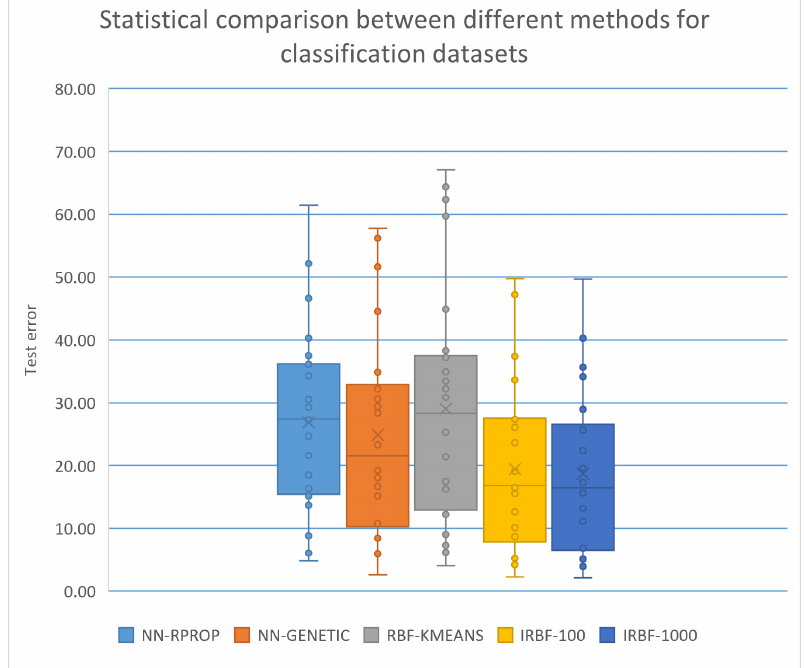
Figure 4. Graphical comparison of all methods for the classification datasets.